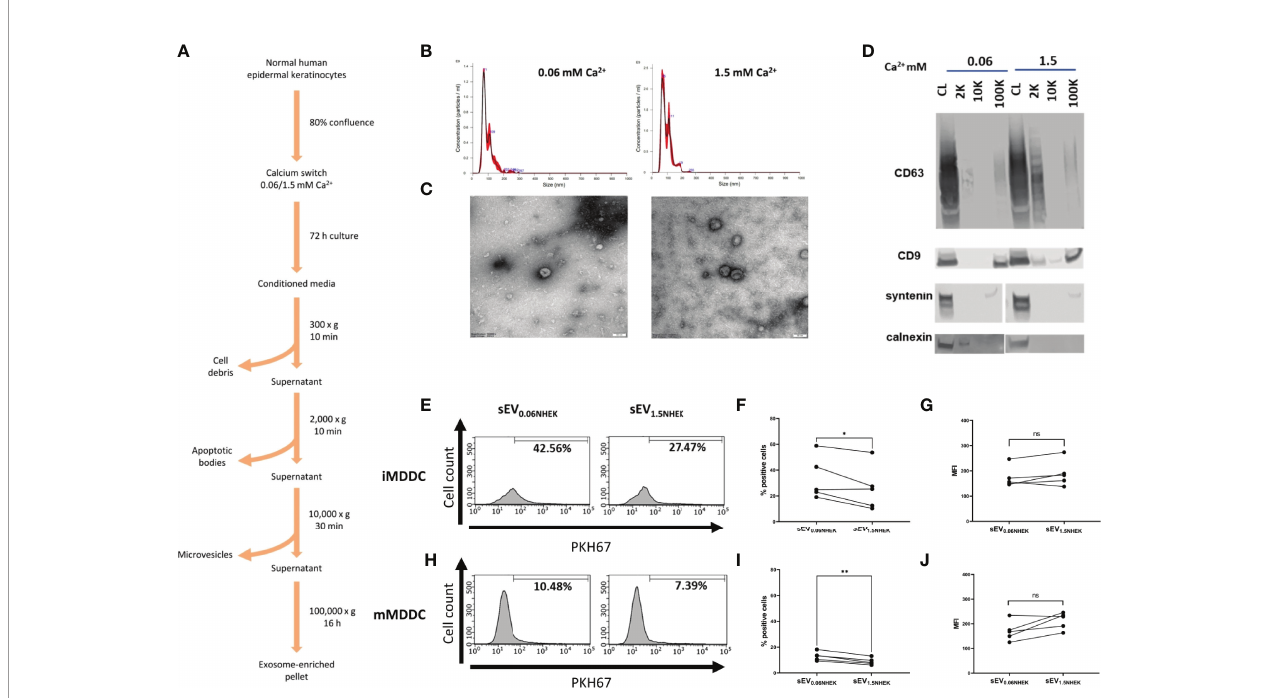
FIGURE 1 | Atopic dermatitis milieu alters properties of keratinocyte-derived small extracellular vesicles (sEVs) which leads to their differential interaction with dendritic cells. (A) Protocol for sEV isolation from NHEK-conditioned medium; (B) size distribution of NHEK-derived sEVs (100K pellet) by Nanoparticle Tracking Analysis (NTA); (C) electron microscopy pictures con fi rming enrichment of cup-shaped exosomes within 100K pellet sEV fraction; scale bar: 50nm; (D) marker expression pattern in 2K, 10K and 100K fractions during isolation, con fi rming enrichment of exosomal makers in the sEV fraction (100K pellet); (E) iMDDC interaction with sEV NHEK secreted under AD cytokine stimulation; example FACS data; (F) iMDDC interaction with sEV NHEK under AD cytokine stimulation; % positive cells data pooled from n = 5 donors; (G) iMDDC interaction with sEV NHEK under AD cytokine stimulation; MFI data pooled from n = 5 donors; (H) mMDDC interaction with sEV NHEK ; example FACS data; (I) mMDDC % positive cells data pooled from n = 5 donors; (J) mMDDC interaction with sEV NHEK under AD cytokine stimulation; MFI data pooled from n = 5 donors; *p < 0.05; **p < 0.01 (paired t-test). ns, not signi fi